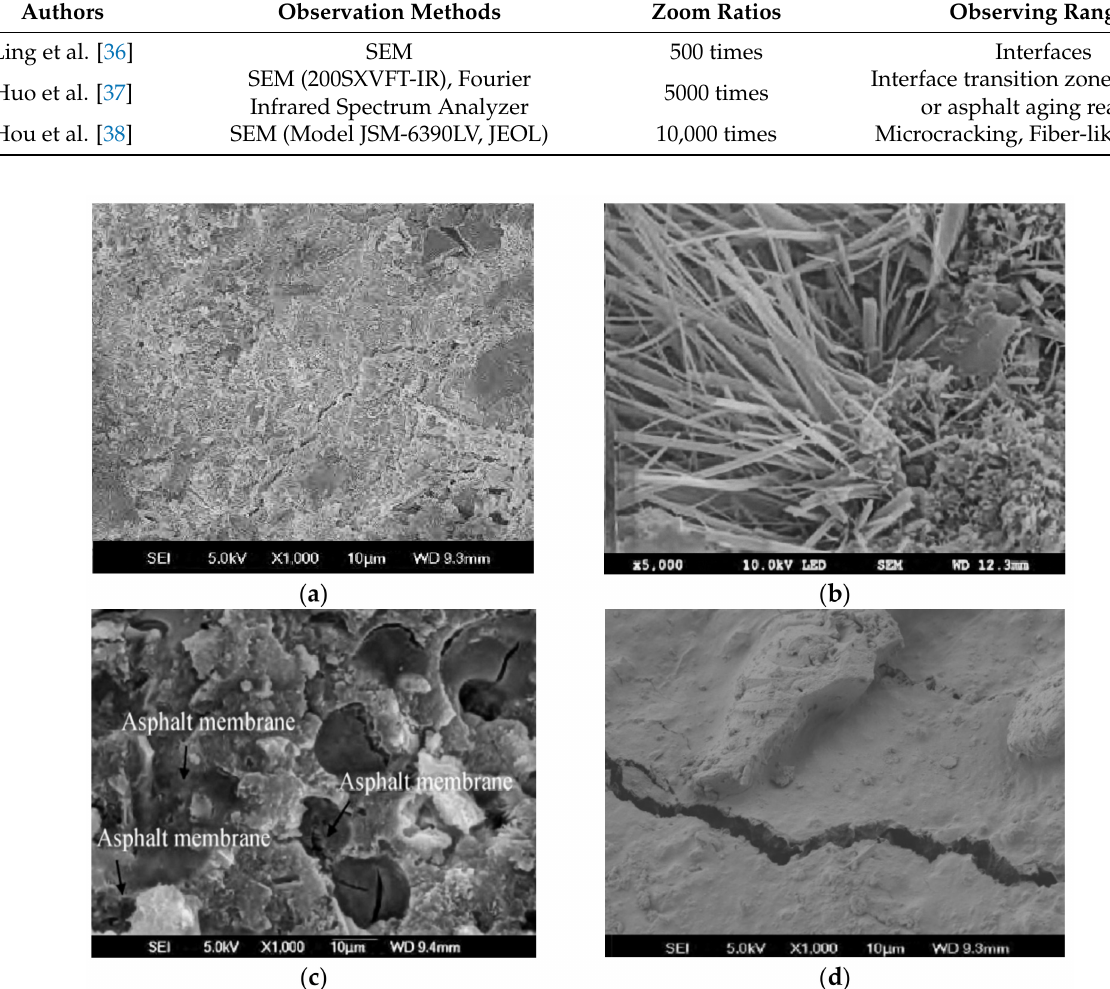
Figure 1. The GSP microscopic images observed by SEM: ( a ) Microstructure at 90-day age; ( b ) Interface and fibrous structures; ( c ) Wrapping phenomenon of asphalt film; ( d ) Generation of micro-cracking and bridging effect of the fiber- like